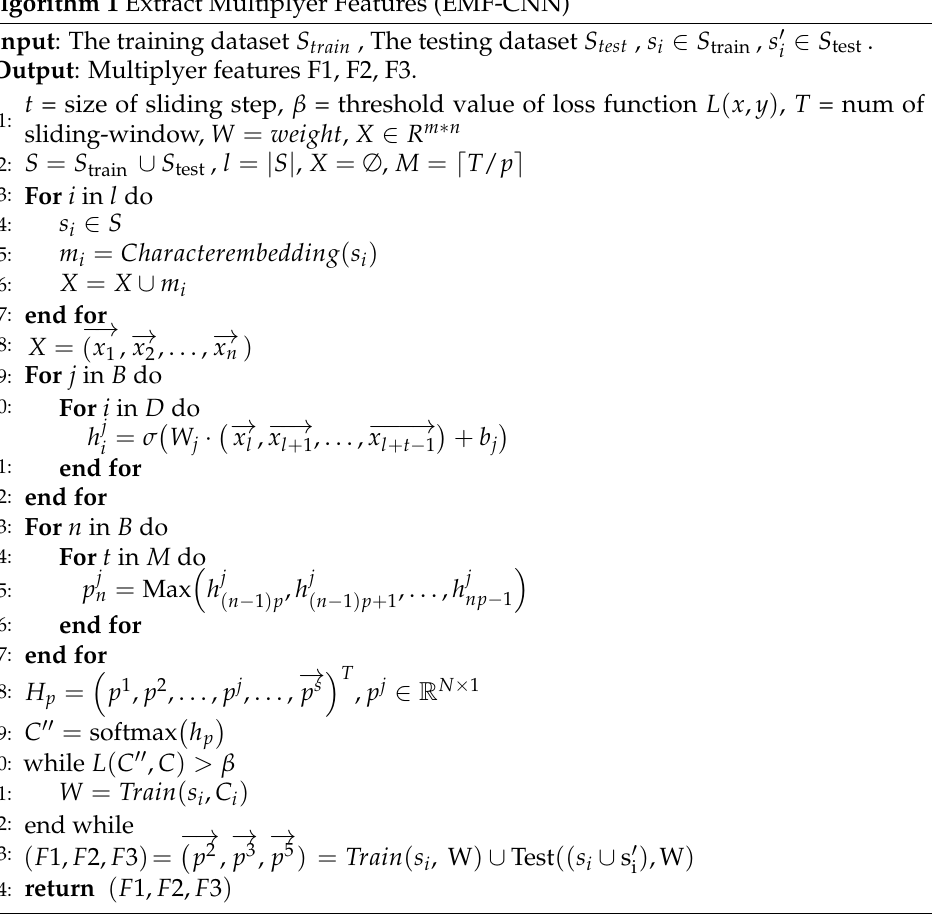
Algorithm 1 Extract Multiplyer Features